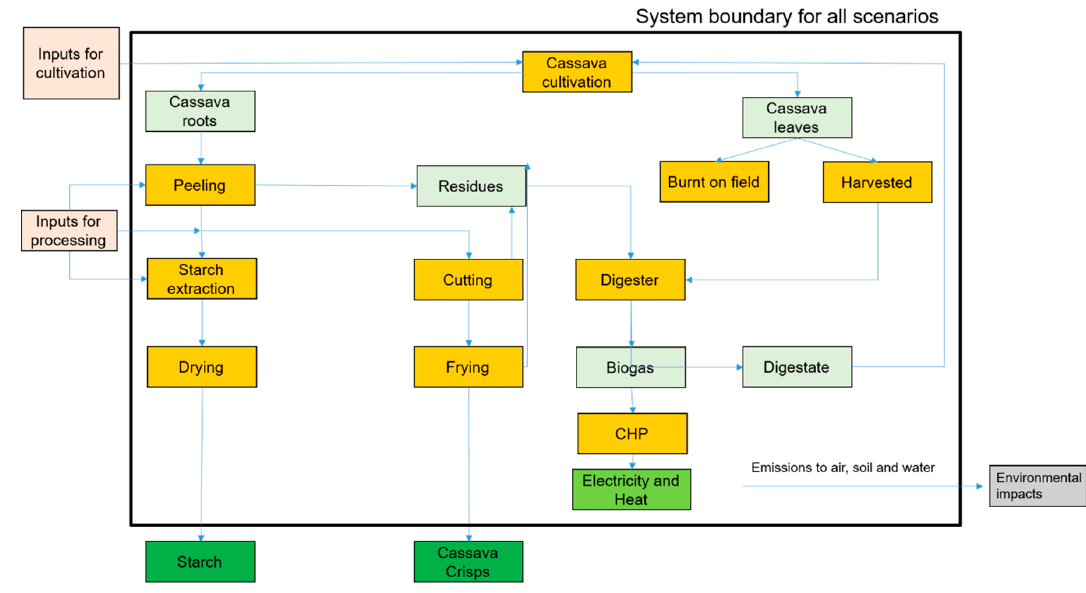
Figure 1. System boundaries of the life cycle assessment (LCA) study (FU: 1 kg of cassava starch, either in the form of dried native starch or based on the corresponding starch content in cassava crisps).